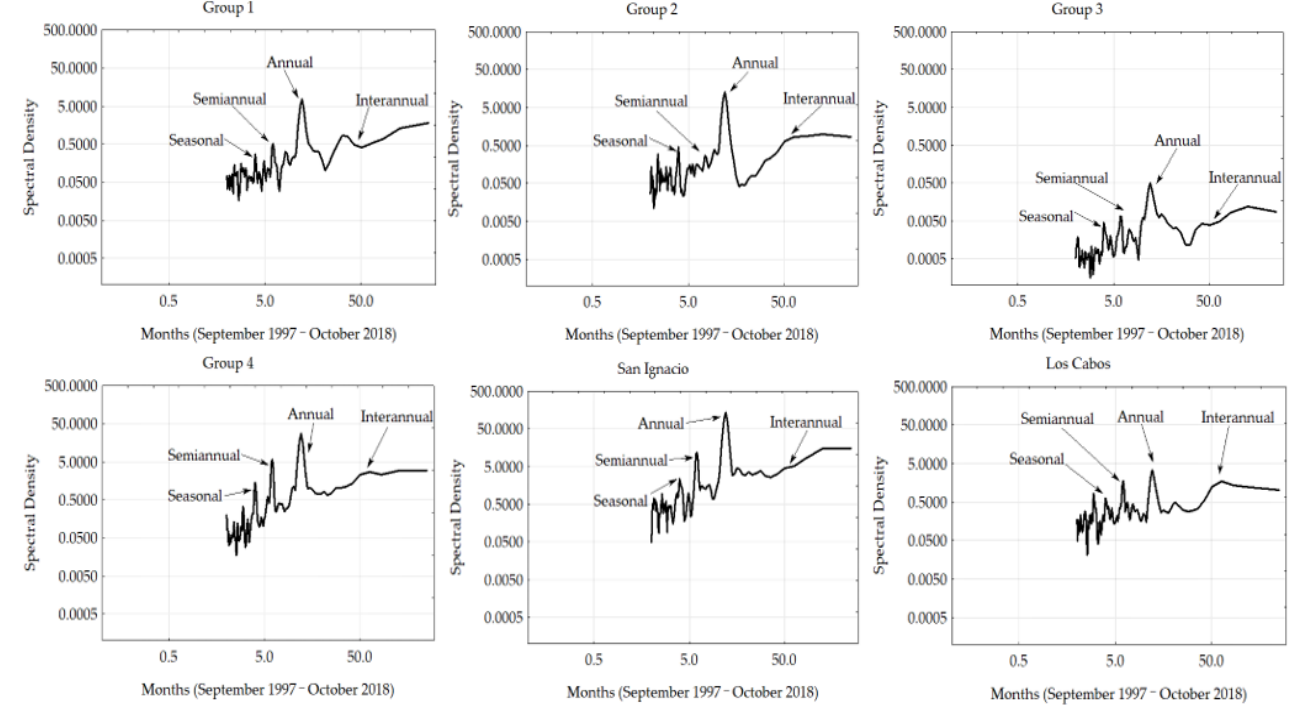
Figure 7. Fourier analyses of Chlorophyll a (Chl a ) concentration for the regions of the northwest of Mexico (Group 1, Group 2, Group 3, Group 4, San Ignacio, and Los Cabos).